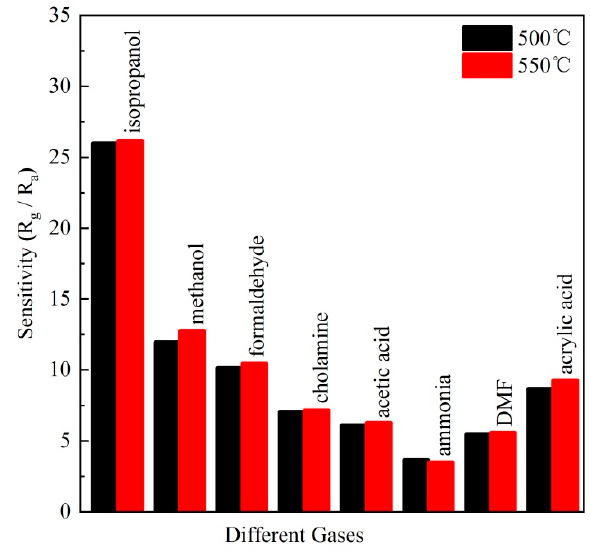
Figure 6. ( a ) Reversibility and ( b ) long-term stability of two BiFeO 3 sensors to 100 ppm isopropanol at 240 °C.